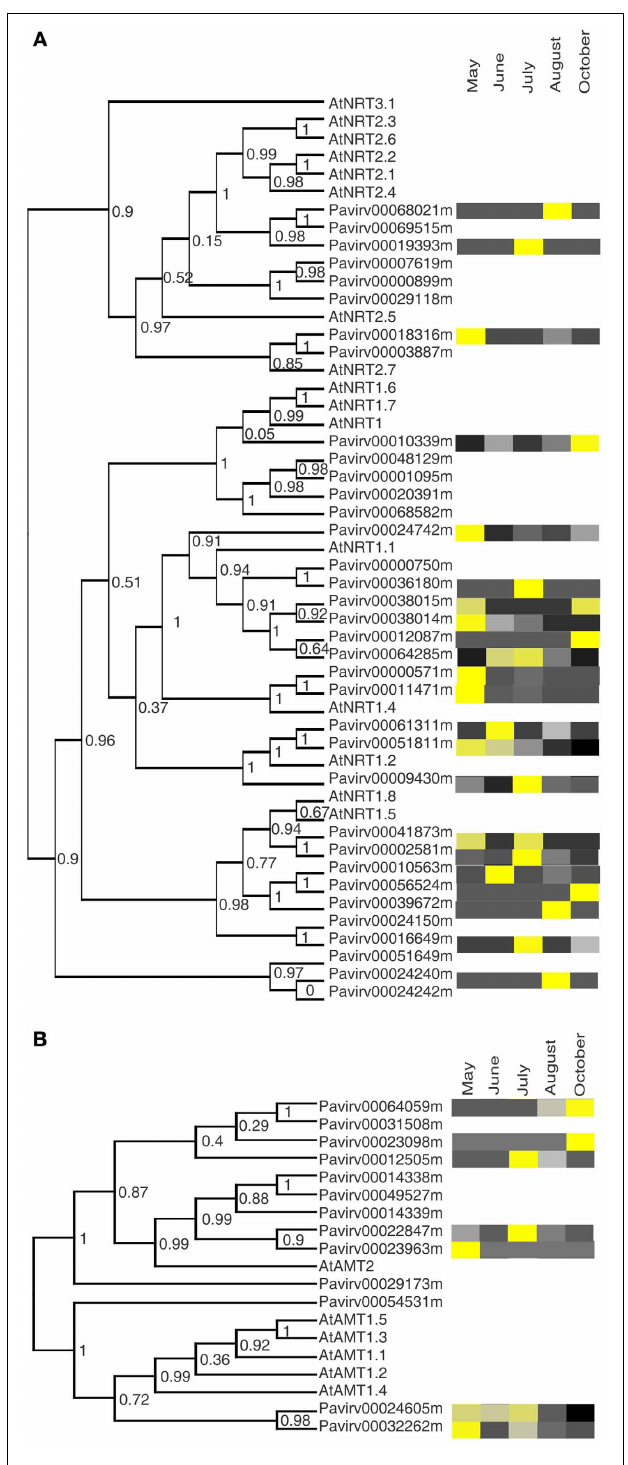
FIGURE 4 | Cladogram of the phylogentic relationships between switchgrass transporter genes to Arabidopsis thaliana orthologs and their expression profiles in crowns and rhizomes of field grown cv Summer plants. (A) Nitrate transporters (NRT) (B) Ammonium transporters (AMT). Other details are as described for Figure 2